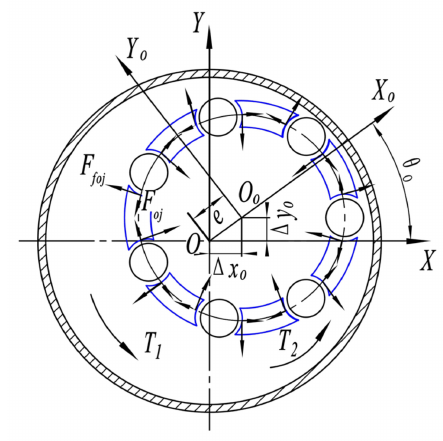
Figure 10. Force model of the